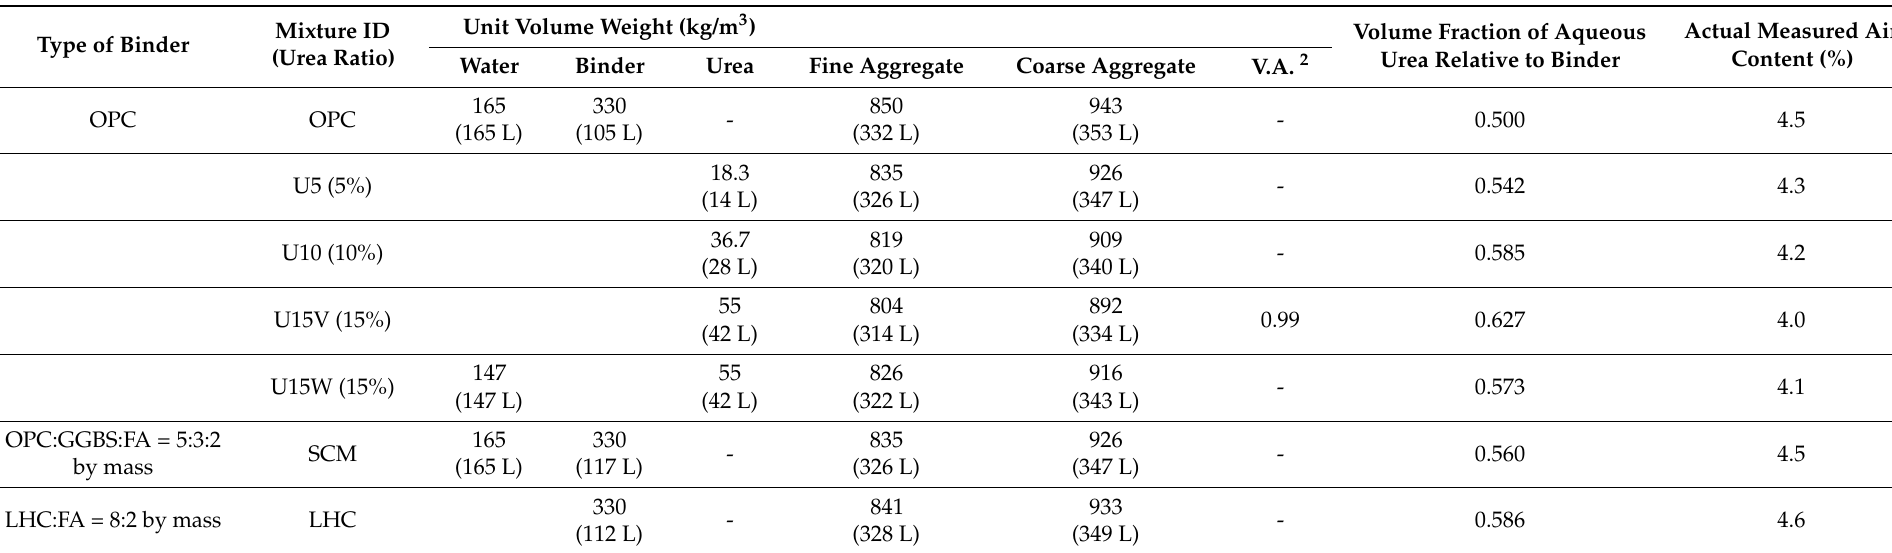
Table 3. Mixture proportion of concrete (W/B: 0.5, superplasticizer: 2.64 kg/m 3 ) 1